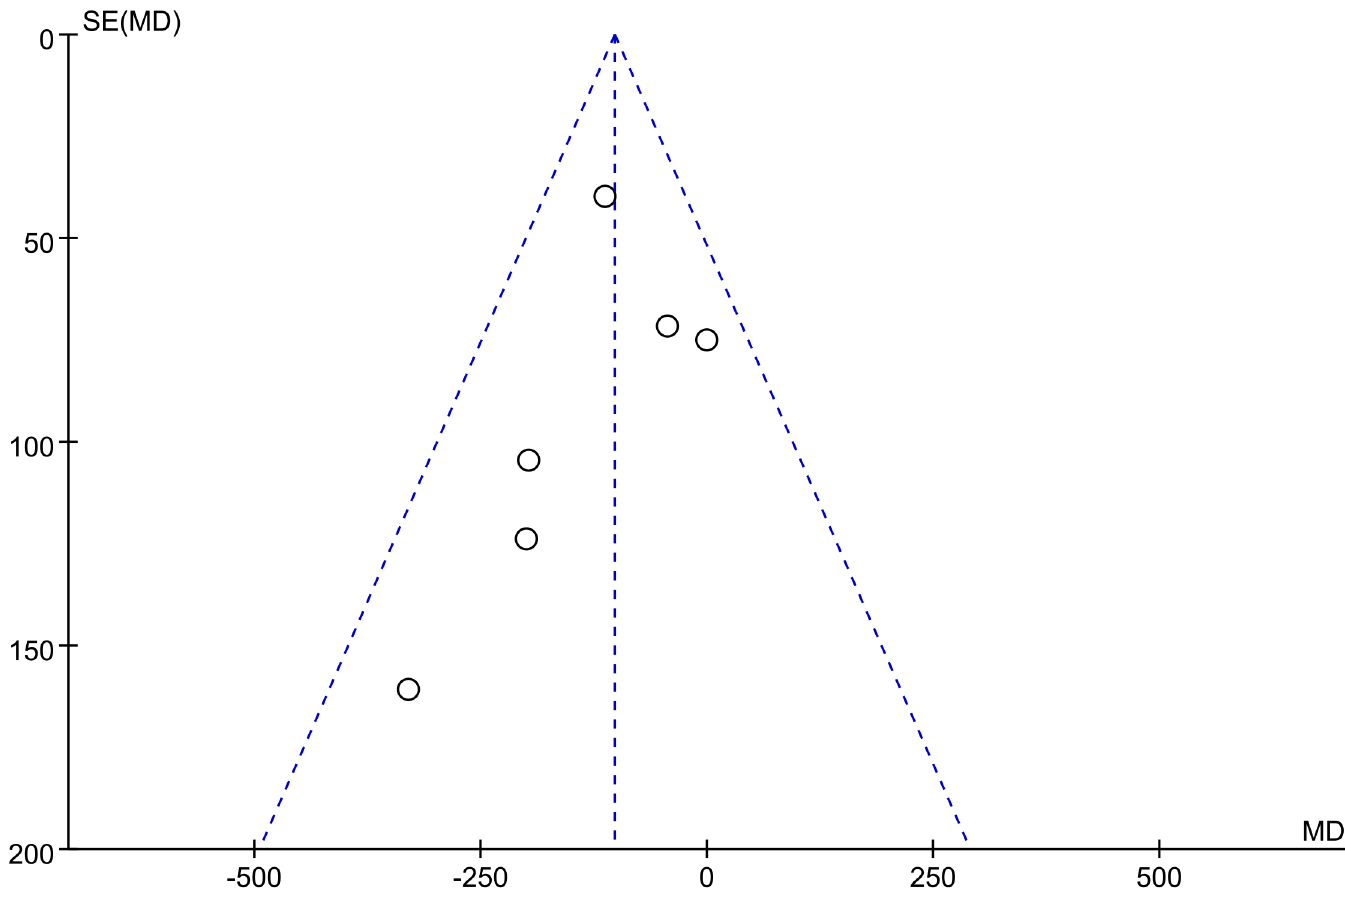
Fig 7. Funnel plot of the value of change of